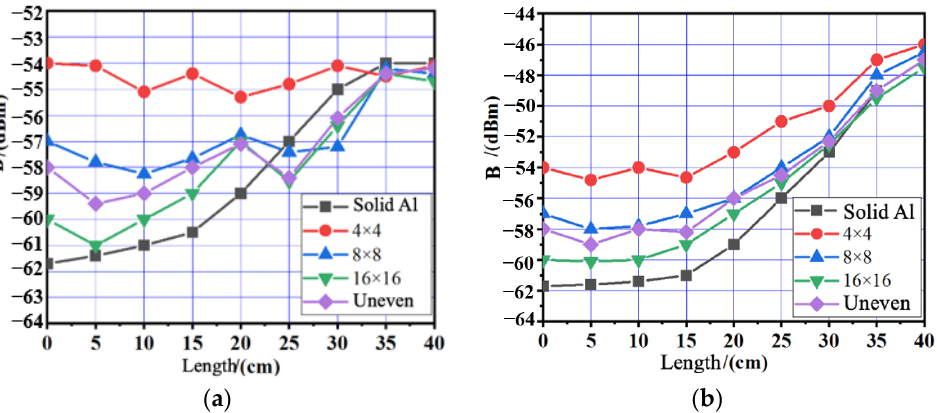
Figure 18. Magnetic field size without loading shielding aluminium plate, ( a ) transverse magnetic field, ( b ) diagonal magnetic field.